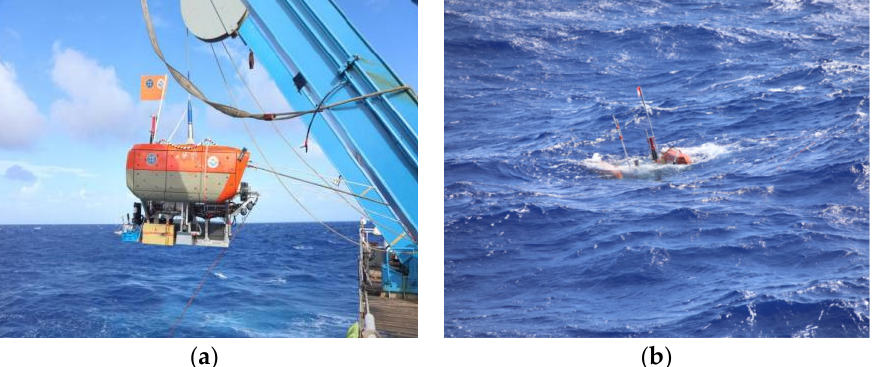
Figure 26. A picture of the ship Shen Kuo.